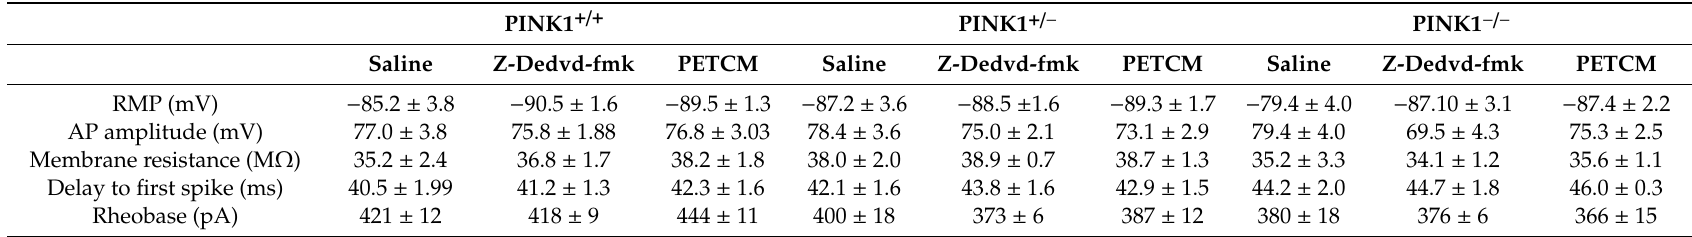
Table 1. Electrophysiological properties of PINK1 MSNs, in the presence of caspase-3